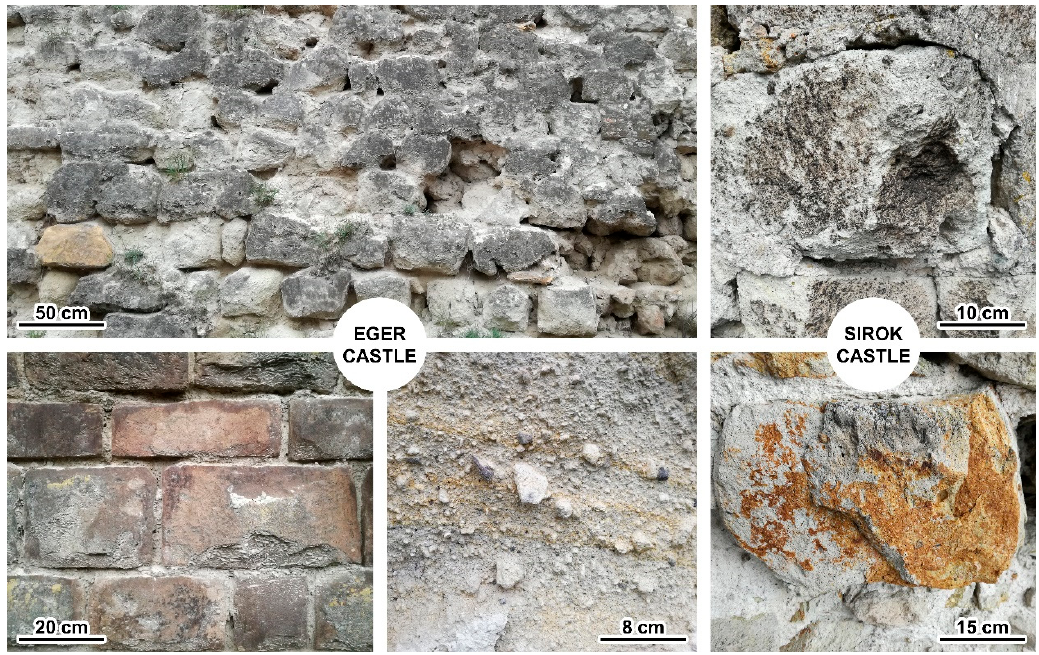
Figure 2. Details of the walls and the weathering observed on the tuff ashlars of Eger Castle (black crusts, patinas, and surface recession with detached crusts, and differential erosion) and Sirok Castle (black crusts and orange patinas).